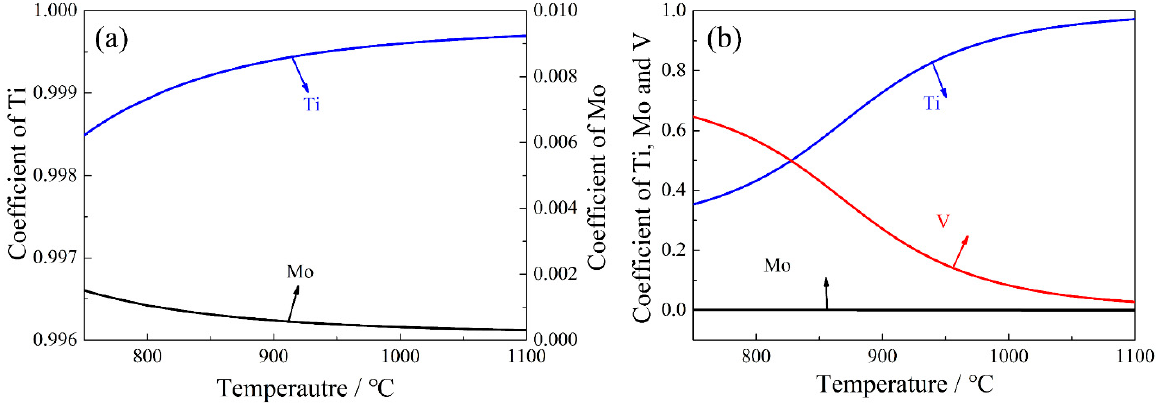
Figure 5. Effects of temperature on the formula coefficient of ( a ) Ti x Mo y C and ( b ) Ti x Mo y V z C in austenite.